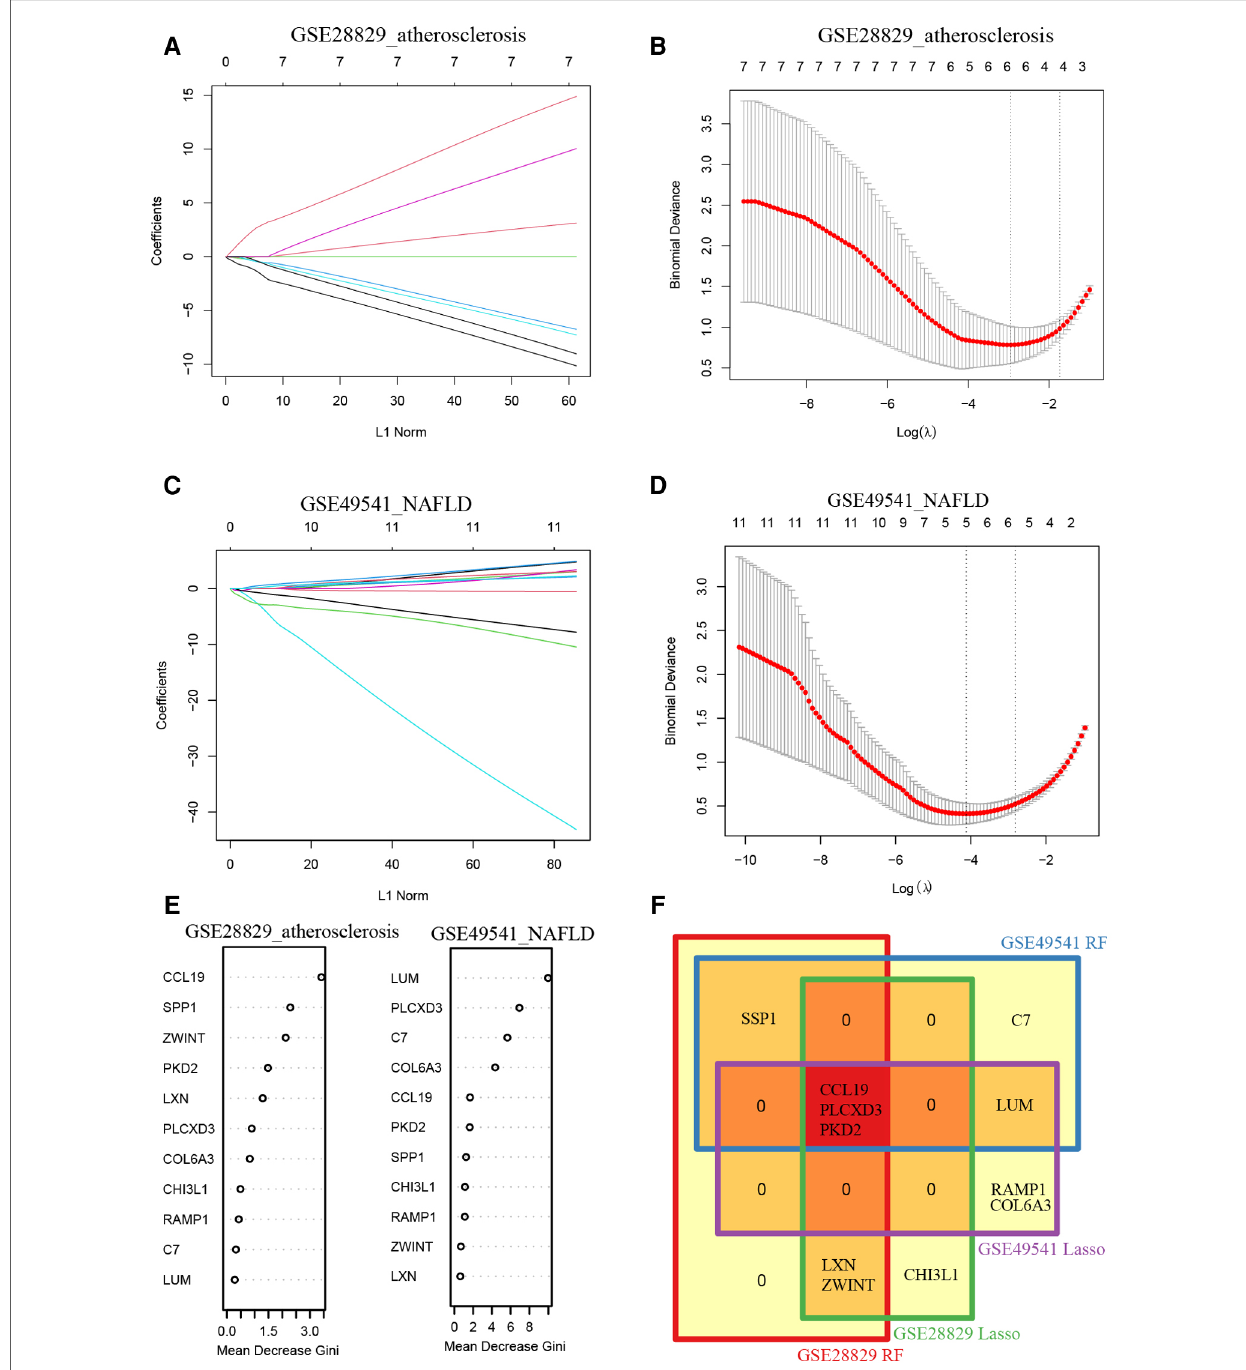
FIGURE 5 Recognition of common signature genes between AS and NAFLD. ( A ) The processes of LASSO regression for identifying variables in GSE28829 and mapping each variable to a curve; ( B ) the log ( λ ) value was optimally selected in GSE28829 by 10-fold cross-validation and plotted by the partial likelihood deviance; ( C ) the processes of LASSO regression for identifying variables in GSE49541 and mapping each variableto a curve; ( D ) the log ( λ ) valuewas optimallyselected in GSE49541 by 10-fold cross-validation and plotted by the partial likelihood deviance; ( E ) the Mean Decrease Gini of each co-DEGs within random forest models for GSE28829 and GSE49541; ( F ) the Venn diagram of 3 common signature genes between GSE28829 and